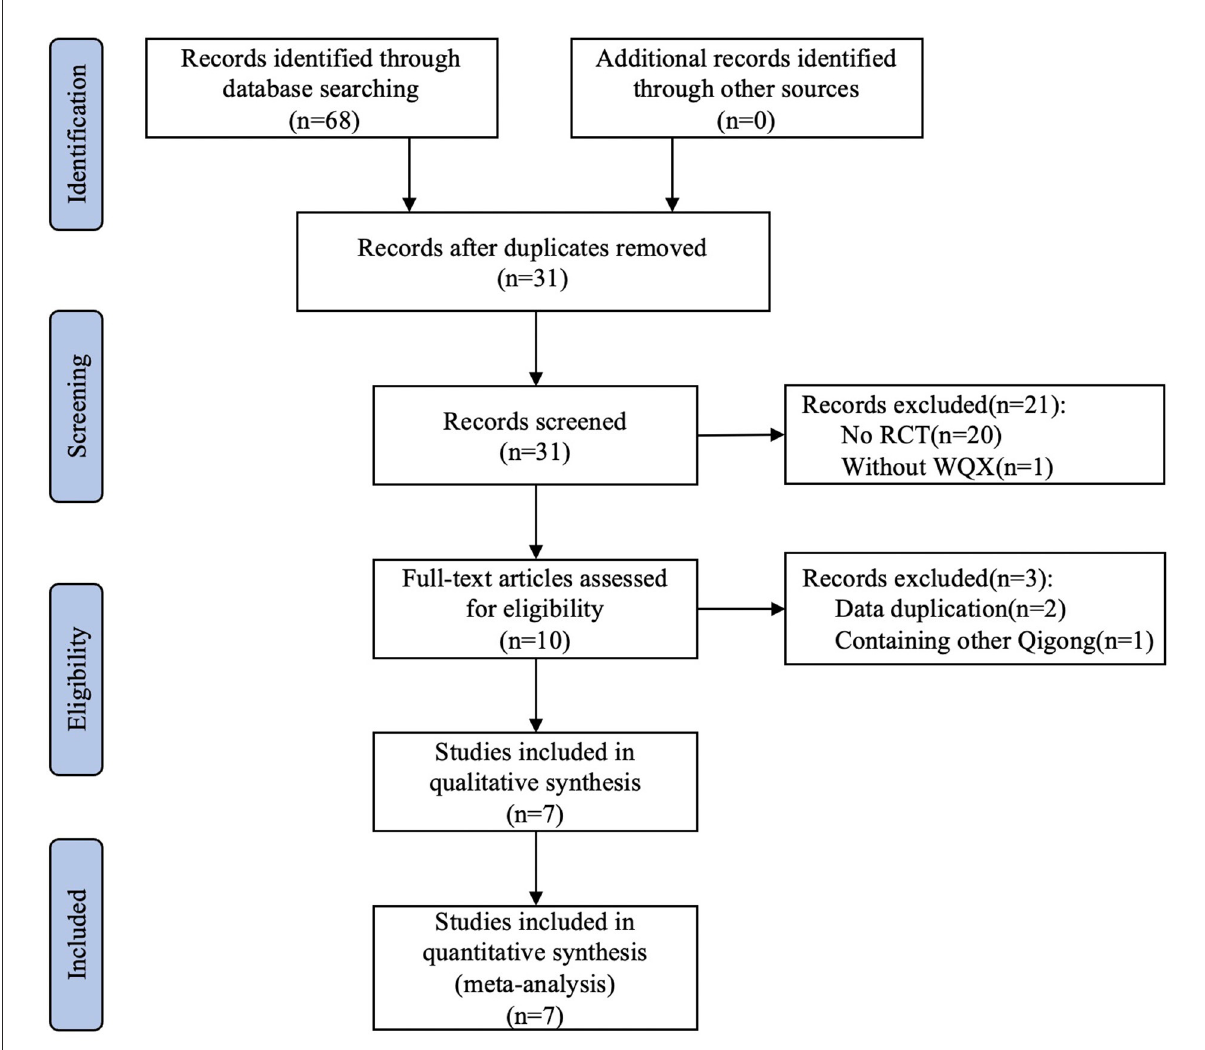
FIGURE1 Flowchart of the trial selection